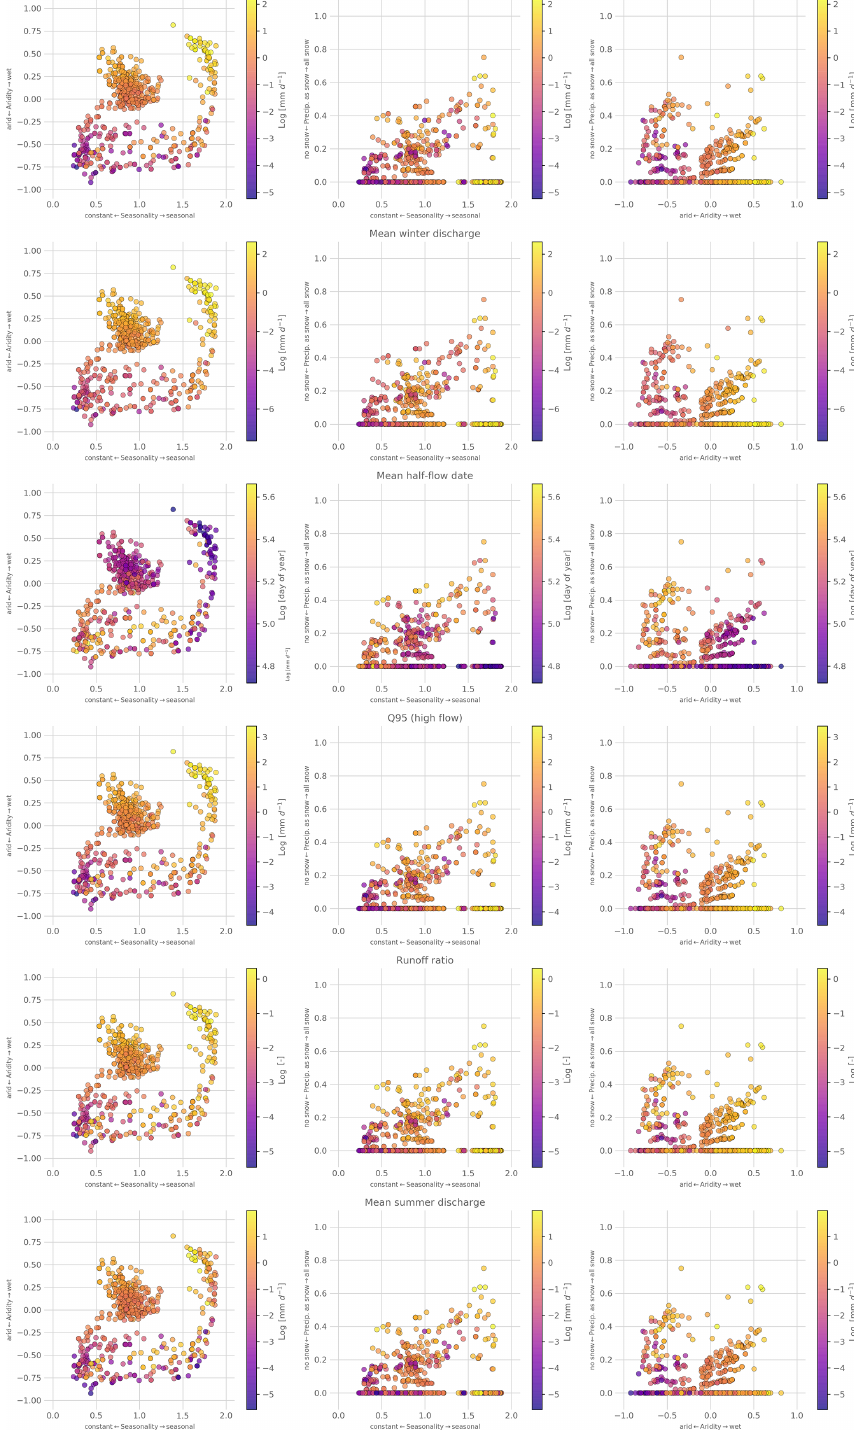
Figure A2. Hydrological signatures for all catchments in the climate index space of Knoben et al. (2018). Single dots show the catchments and are colored according to the value of the mean annual discharge. The log of the signatures is used to show the relative differences between the